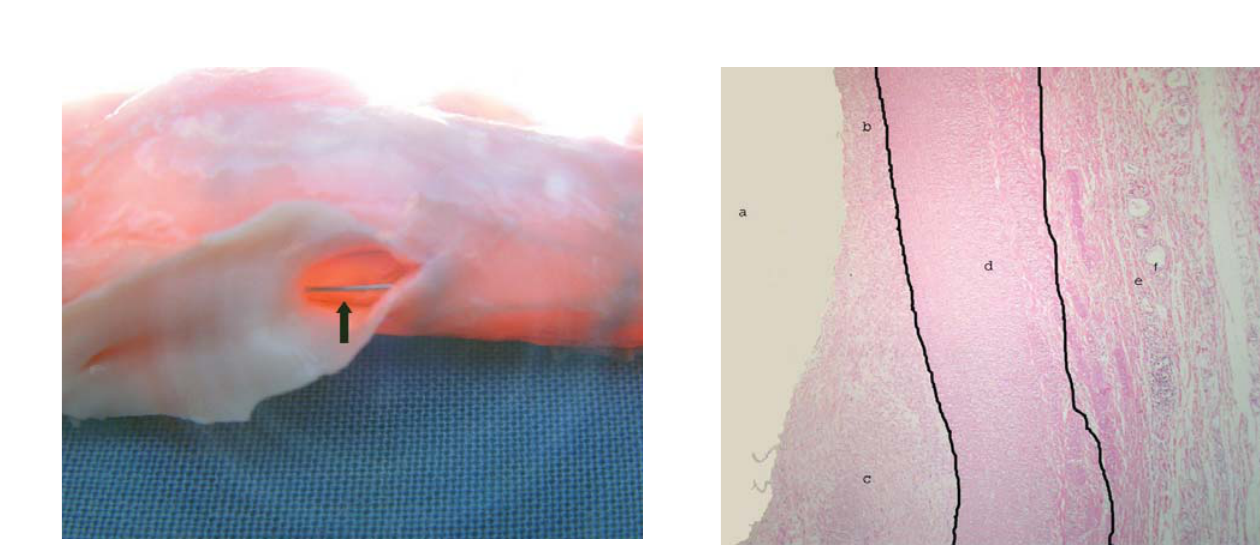
Fig. 4 - Corte longitudinal na transição entre o segmento distal normal e o espessamento gradual da aorta: (a) luz da aorta, (b) camada íntima com espessura normal, (c) camada íntima espessada (extremidade mais próxima do stent) com acúmulo de fibroblastos e colágeno, (d) camada média (muscular) contendo células musculares lisas, (e) camada adventícia contendo células